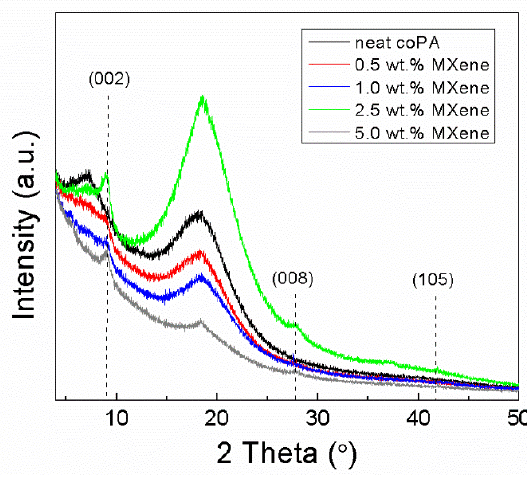
Figure 6. XRD spectra of the coPA/MXene films.